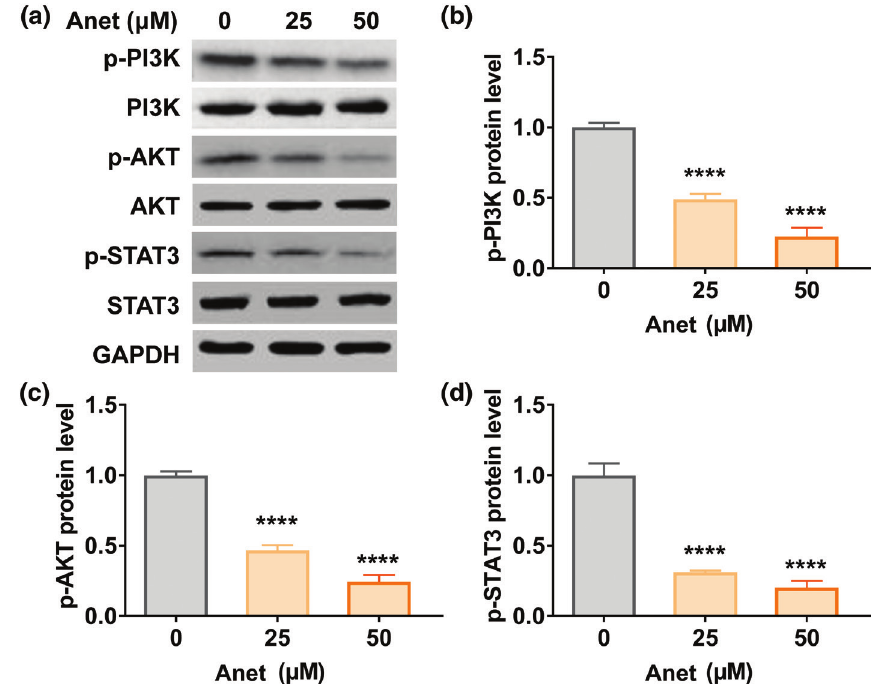
Fig. 4. Anethole regulated AKT and STAT3 signaling in A549 cells. A549 cells were treated with vehicle, 25, or 50 μM anethole for 6 h and then harvested to analyze the protein level of p-PI3Kp85 α (a and b), p-AKT (a and c), and p-STAT3 (a and d) by Western blot. Four replicated wells for each condition. Error bar represents SEM. **** P <